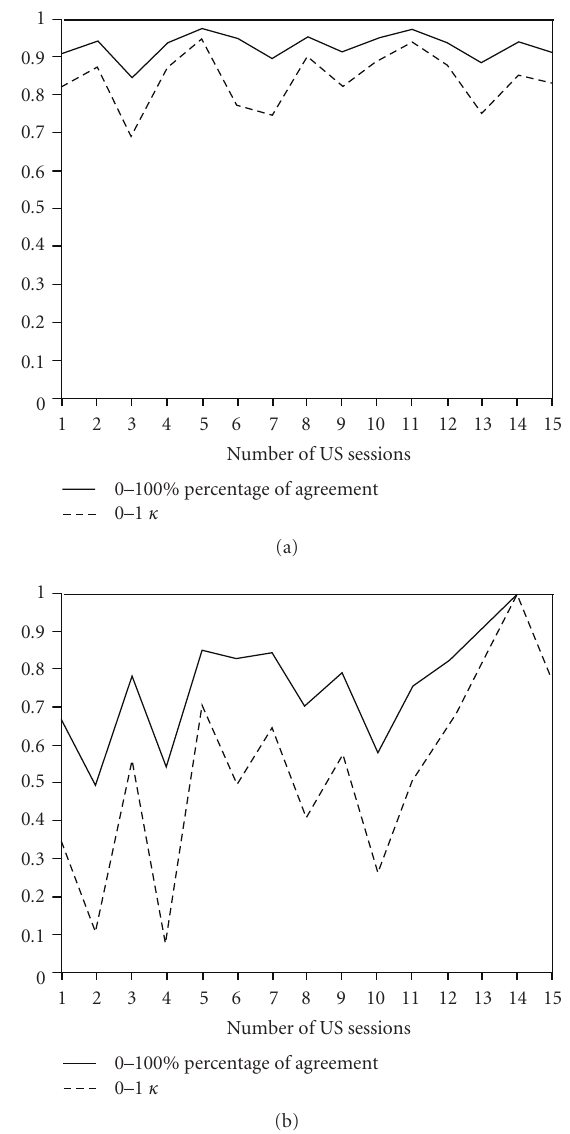
Figure 2: (a) Interreader agreements between senior and junior. Grade of agreement and κ coe ffi cients from the first to the 15th US session for the junior investigator. (b) Intereader agreements between senior and beginner (learning curve). Grade of agreement and κ coe ffi cients from the first to the 15th US session for the beginner